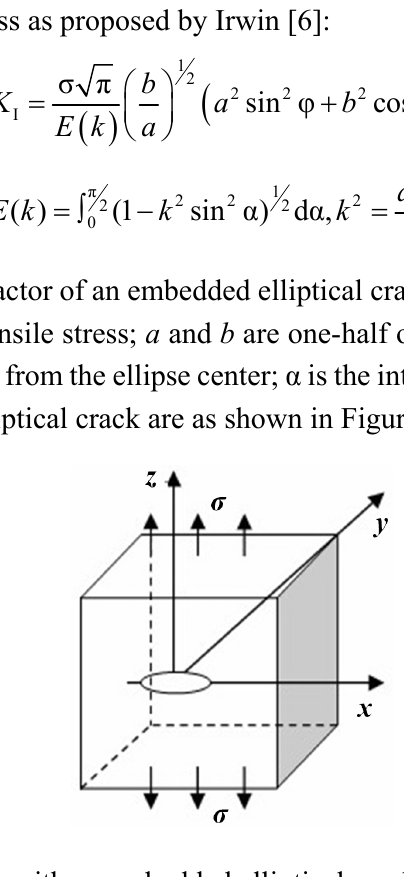
Figure 1. Infinite elastic matrix with an embedded elliptical crack subjected to uniform tensile stress.